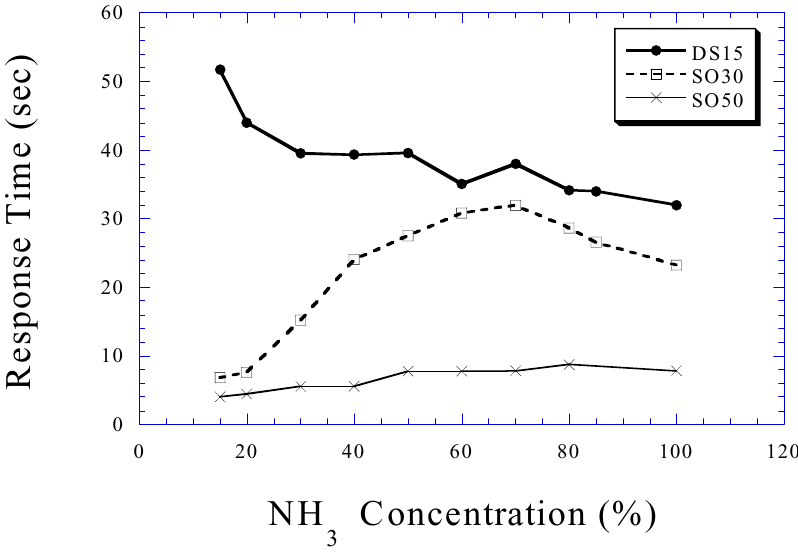
Figure 18. Sensor response times to changing ammonia